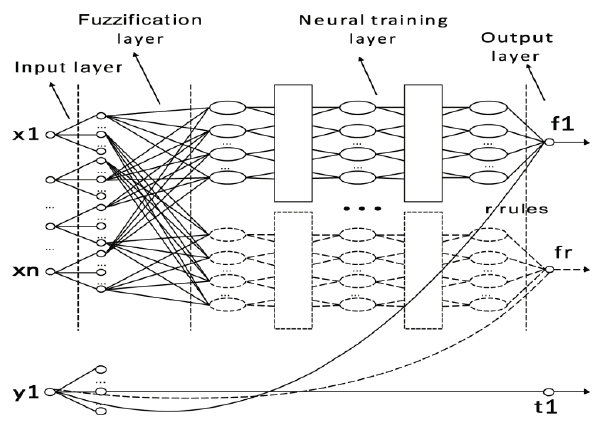
Figure 2. Fuzzy rule-based neural